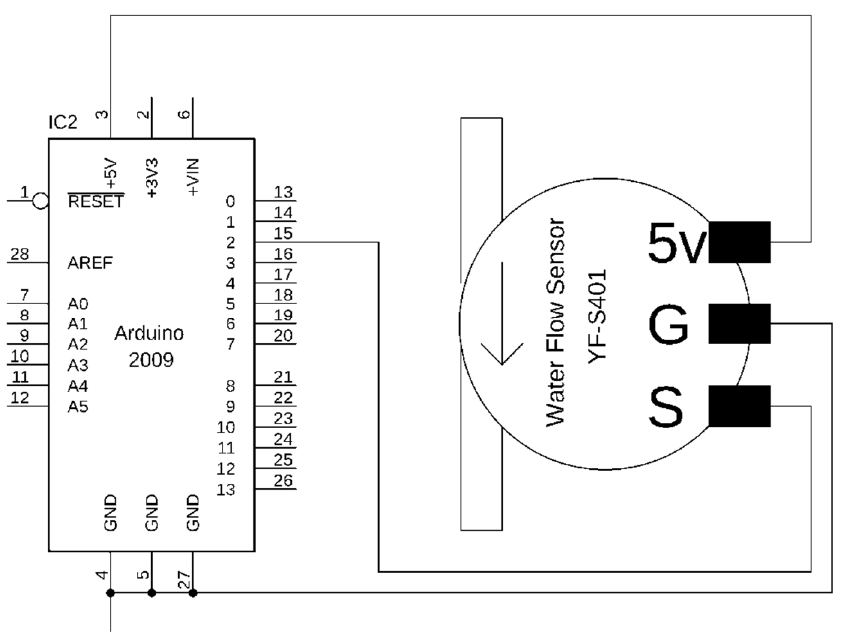
Figure 6. Circuit diagram of water flow sensor namely YF-S401.